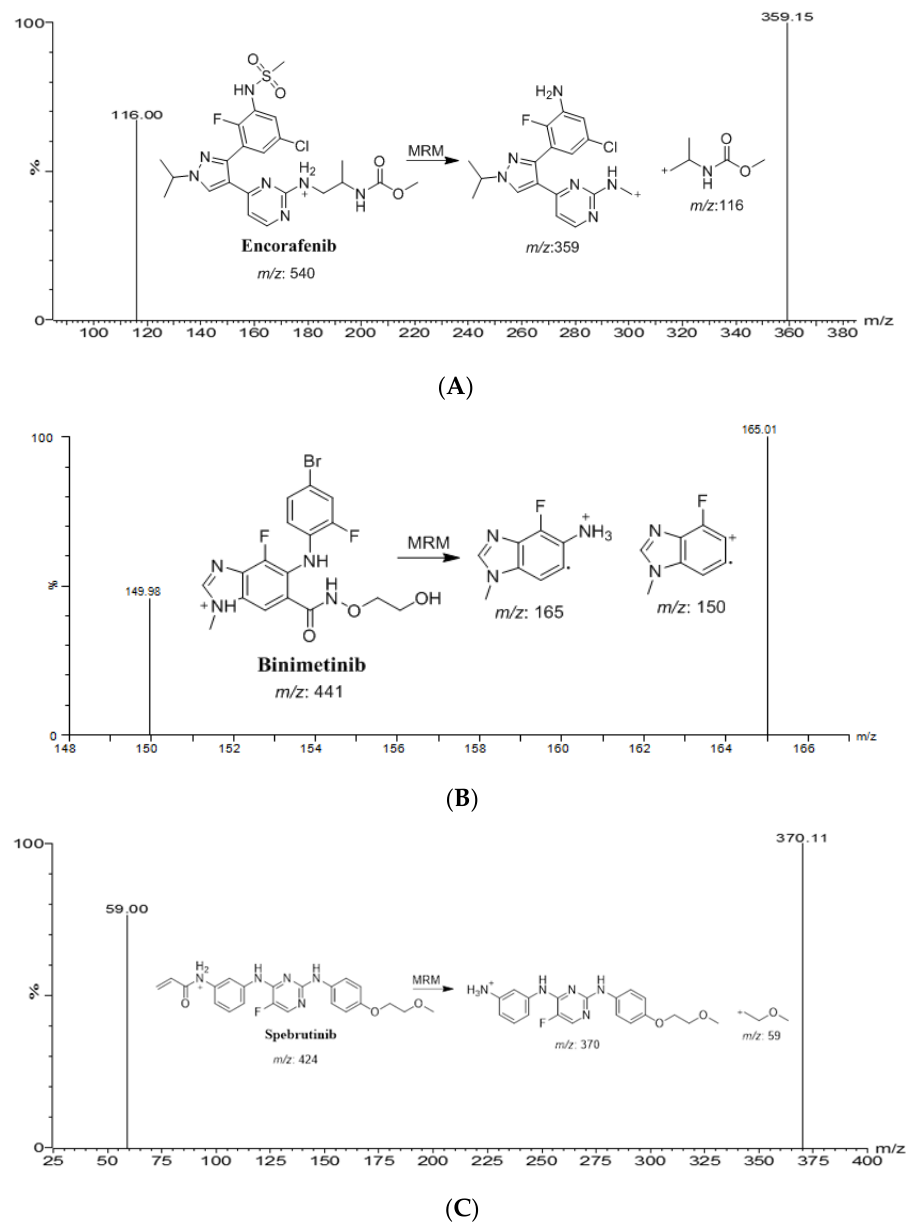
Figure 2. Multiple reaction monitoring (MRM) mass spectra and the expected fragmentation pathway of encorafenib ( A ), binimetinib ( B ), and spebrutinib ( C ) (IS).